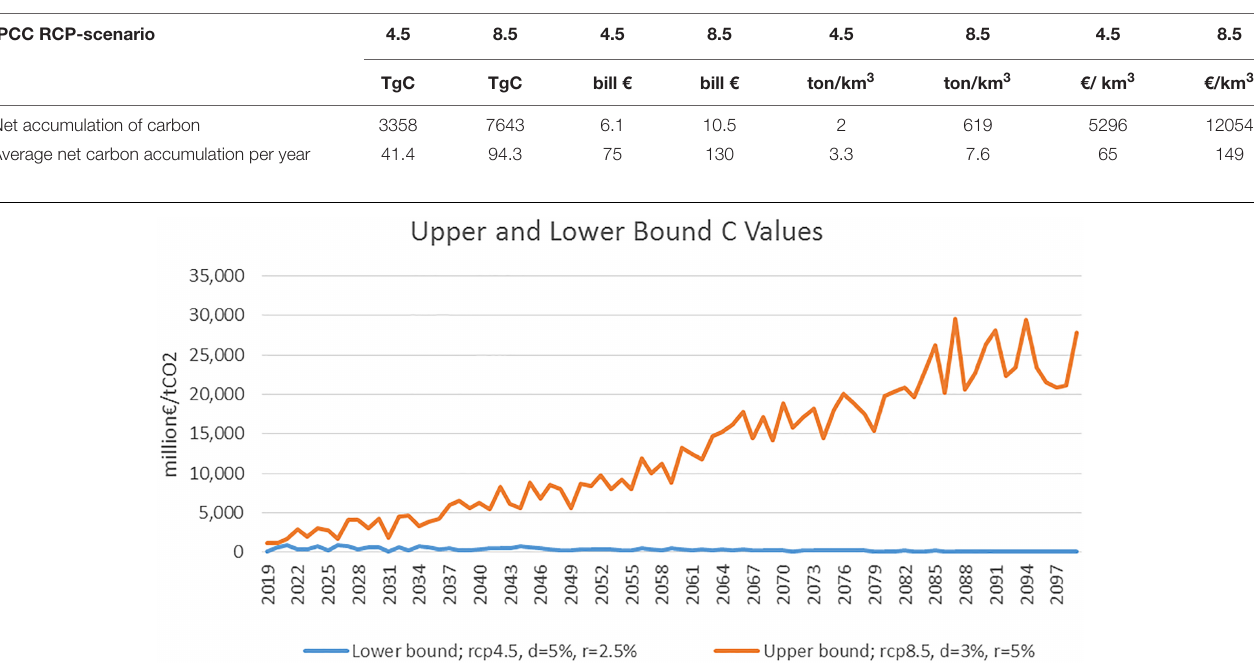
TABLE 2 | Total and average increased carbon storage and value in the Arctic Ocean, 2019–2099, with current EU ETS market price (€19.46 per tonne), with zero price growth and discount rates.